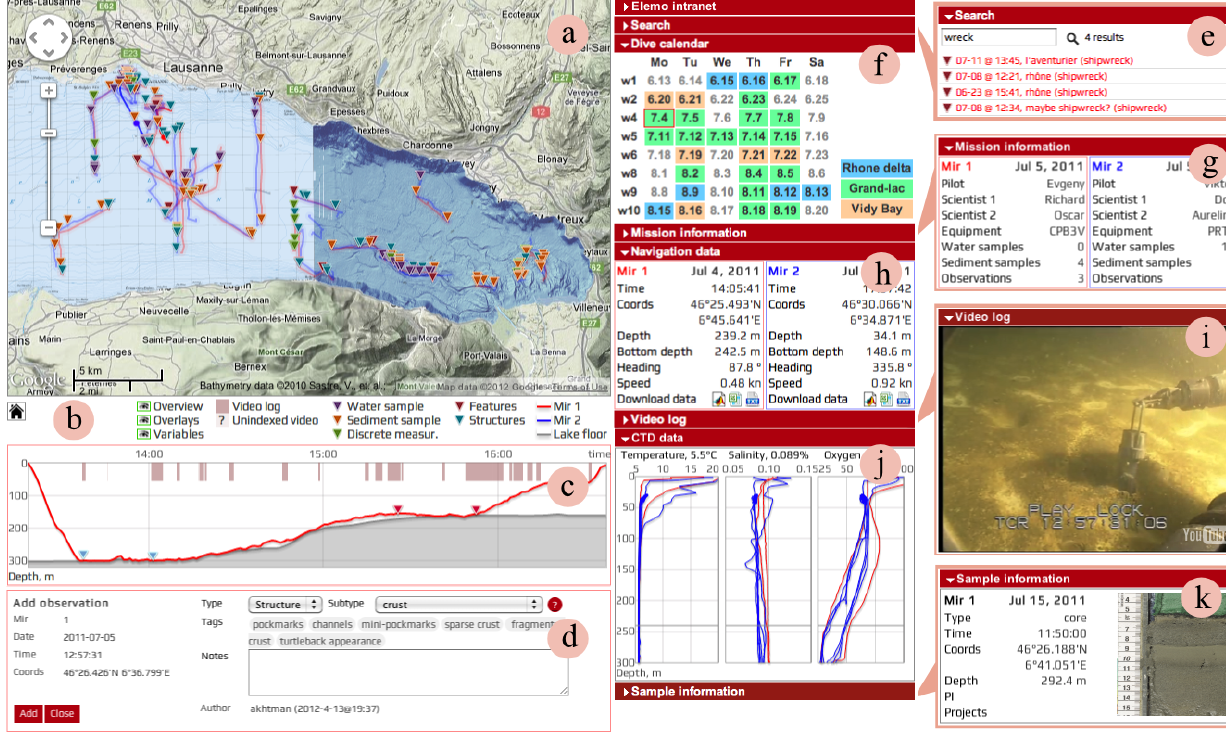
Figure 6: Main components of the current implementation of the ´El´emo project data browser: (a) Google maps-based two-dimensional interactive map; (b) visualisation key; (c) timeline with depth versus time dive profile; (d) observation entry/editing form; (e) search form; (f) field campaign dive calendar; (g) mission information (h) navigation data; (i) video log; (j) master environmental variables (temperature, salinity and oxygen); (k) sample information (sediment analysis courtesy of Corella et